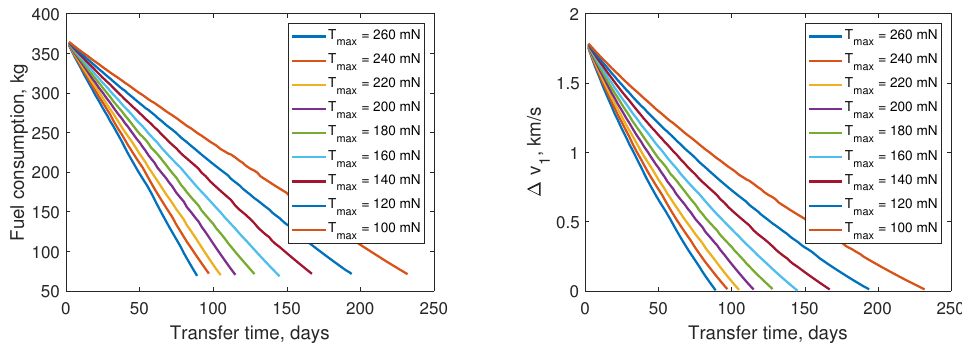
Figure 7. The variation in fuel consumption with transfer time and variation in magnitude of impulsive burn with transfer time for different values of T max when I sp = 3000 s.